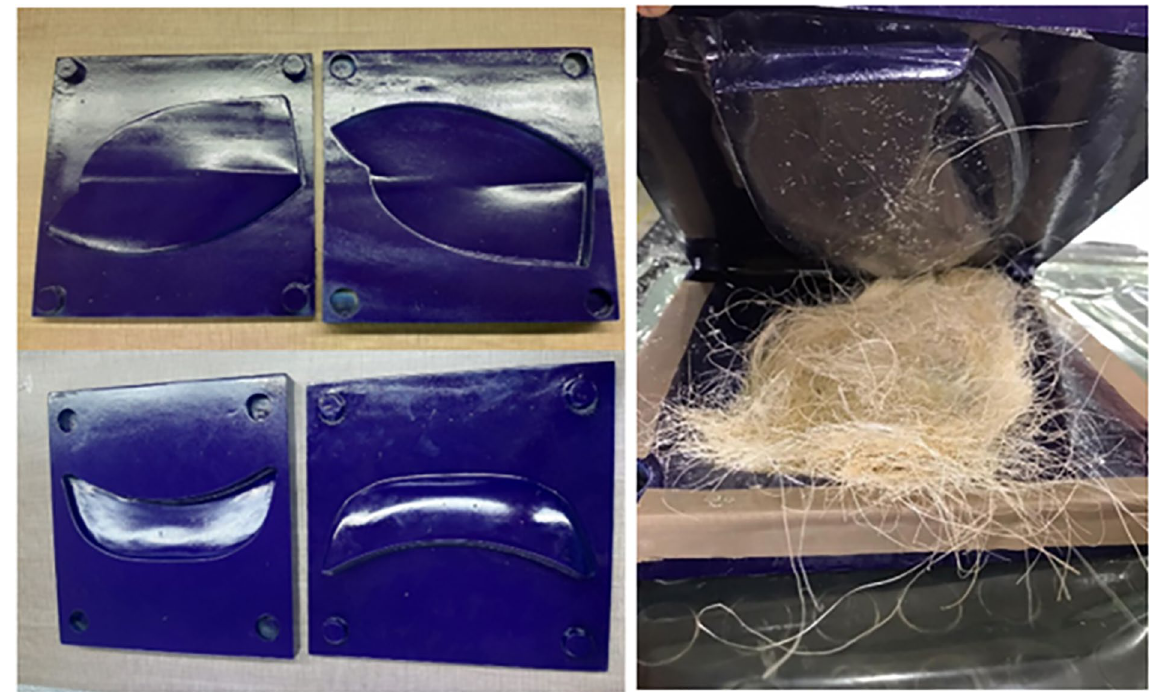
Figure 3. Molds and configuration used for manufacturing automotive parts with the resin film infusion process.